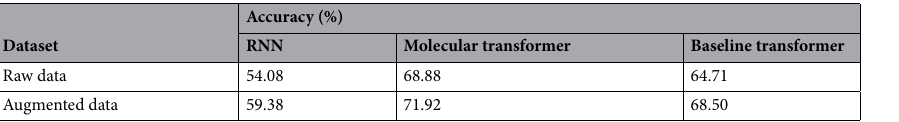
Table 4. The reaction prediction accuracy of Chan-Lam reaction before and after augmentation was compared under different models.